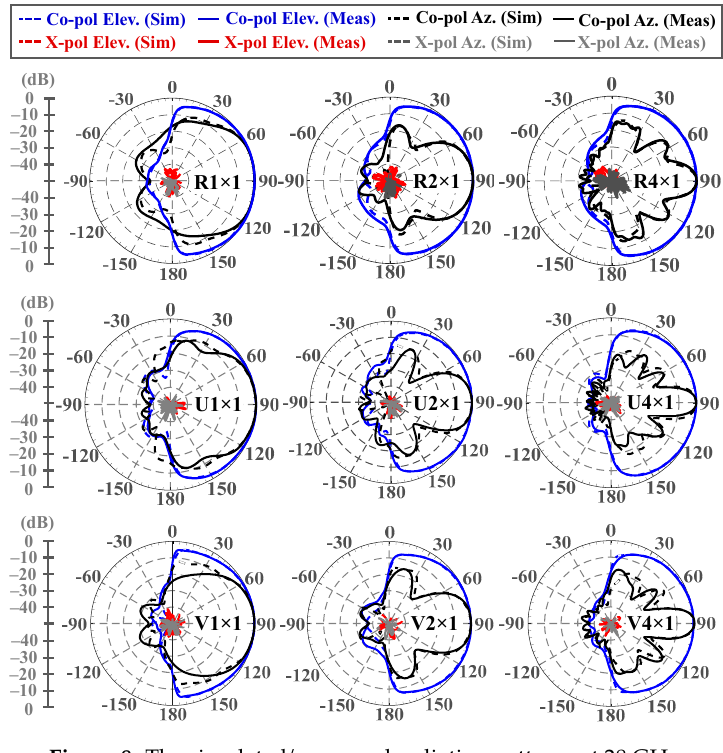
Figure 8. The simulated/measured radiation patterns at 28 GHz.